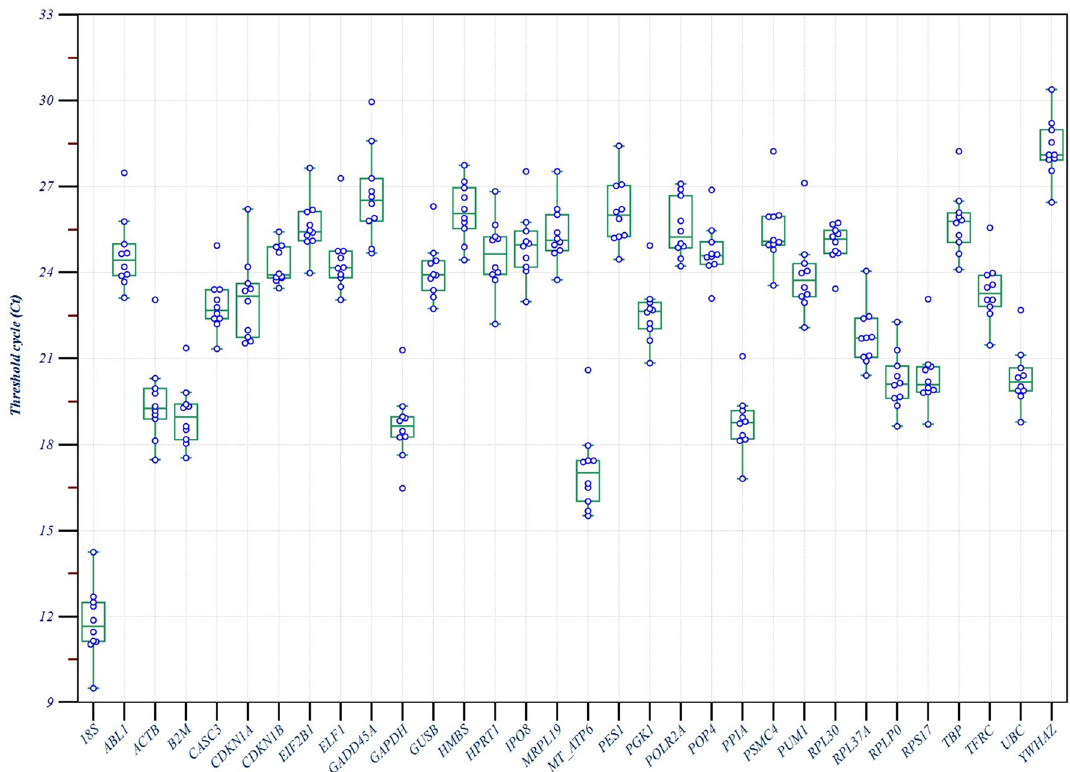
Figure 1. Box plots and dots of Ct values for the 32 candidate reference genes. The box represents the values from the lower (Q1—25th percentile) to the upper quartile (Q3—75th percentile). The horizontal line inside the box represents the median. Minimum [Q1 − (1.5*IQR)] and maximum [Q3 + (1.5*IQR)] values are represented by whiskers, excluding outlier values, which are displayed as separate points (blue circles outside). The sample distribution is represented by blue circles. IQR interquartile range. The box-plot was generated using MedCalc statistical software version 19.5.1 (MedCalc Software Ltd, Ostend, Belgium; https ://www.medca lc.org;